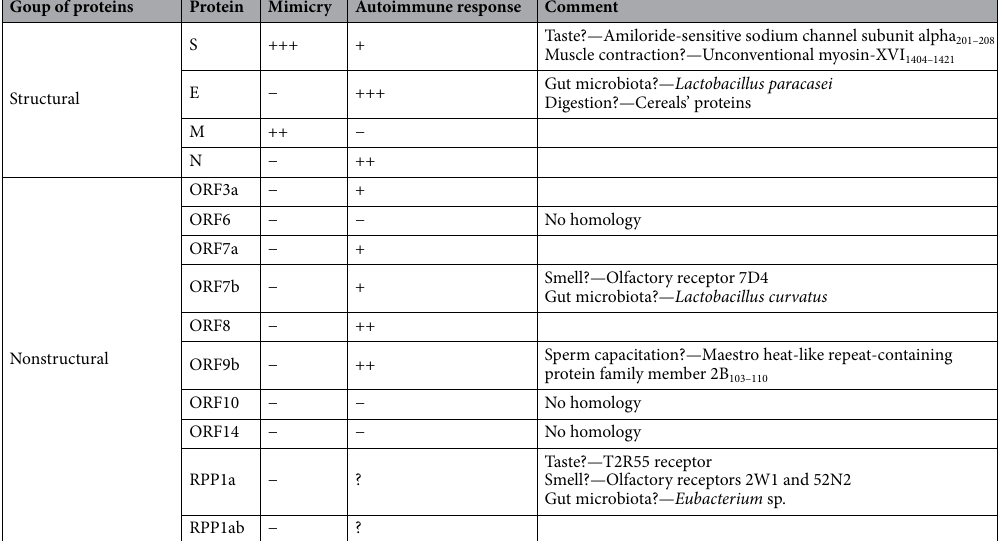
Goup of proteins Protein Mimicry Autoimmune response